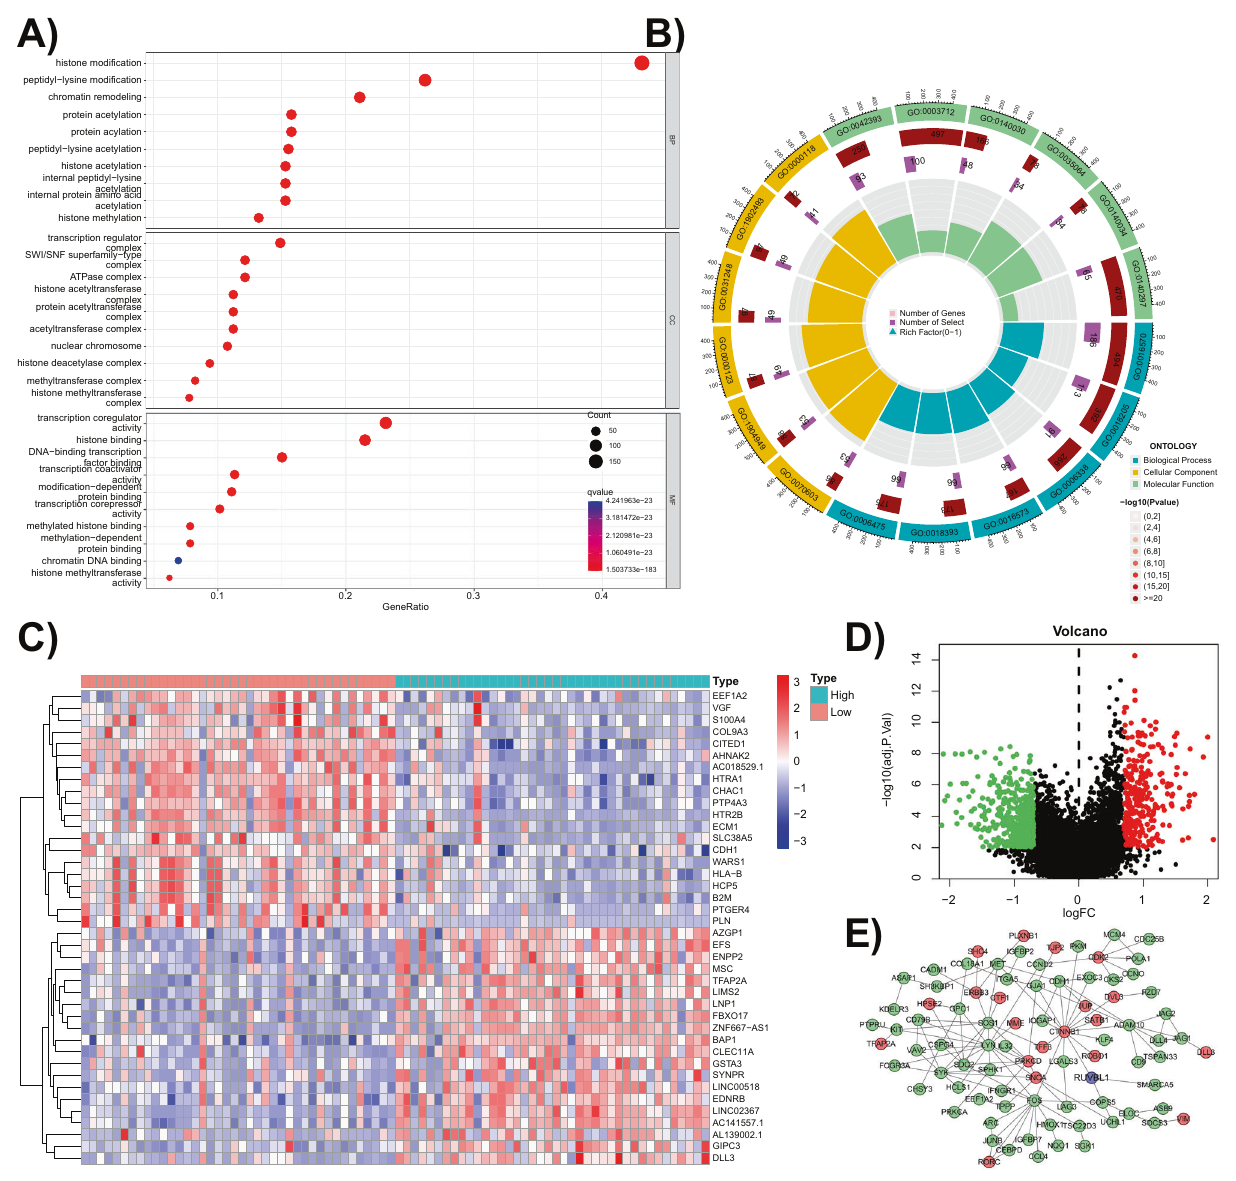
Fig. 3 Online database analysis for the biological function of RUVBL1. A The bubble chart displaying GO enrichment analysis of the DEGs in the GEO database (the abscissa indicates the proportion of the genes, the ordinate indicates the GO node, each circle represents the DEGs enriched at the node, larger circles re fl ect more enriched genes, and the deeper color of the circle re fl ects more signi fi cant enrichment of the gene at the node). B The circle chart displaying GO enrichment analysis of DEGs in the GEO database; the outermost circle is the biological process (blue), molecular function (green) and cellular composition (yellow) of the GO analysis and the number is the GO node number; the second circle is the number of genes enriched to each GO node and the deeper color re fl ects more signi fi cant enrichment of the DEGs; the third circle is the number of DEGs at each GO node; the innermost circle represents the gene ratio). C Heatmap of differential analysis of TCGA database showing the expression level of the 20 most signi fi cantly upregulated (red) and downregulated (blue) genes in the high and low RUVBL1 expression groups; the darker the color, the more signi fi cant the difference. D The volcano plot of differential analysis on TCGA database (each point represents the expression of a gene, red indicates signi fi cantly high expression, and green indicates signi fi cantly low expression). E PPI network of DEGs in TCGA (each circle represents a gene, upregulated genes are shown in red, downregulated genes in green, and the target gene, RUVBL1, in blue). [17]. Also, the prognostic and diagnostic potential of RUVBL1 in chromatin remodeling, and enhancing the transcription activity of oral squamous cell carcinoma has been uncovered [18]. Further- CTNNB1, thus in contribution to the progression of UVM (Fig. 7). more, the implication of RUVBL1 in differentiation, proliferation The initial fi nding from this study supported that RUVBL1 was and invasion of head and neck squamous cell carcinoma cells has expressed at a high level in UVM samples and cells, acting as an been documented by incorporating histone variant H2AZ in independent prognostic factor. Largely in agreement with our fi nding, highly expressed RUVBL1 in non-small cell lung cancer has chromatin, highly suggestive of its functional role in evaluating prognosis [19]. In addition, silence of RUVBL1 exerts inhibitory been reported to be indicative of undesirable oncogenic out- effect on malignant cell proliferation both in vitro and in vivo in comes of patients, serving as a promising prognostic biomarker